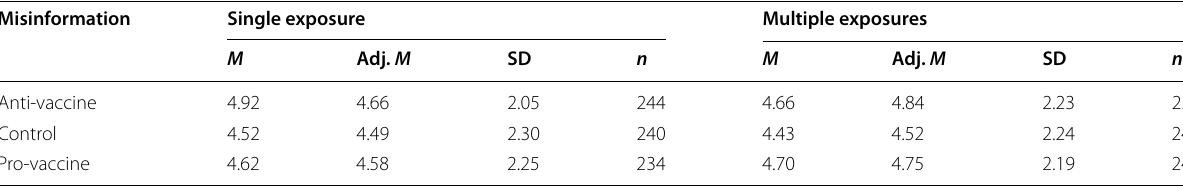
Table 3 Descriptive statistics of vaccination intentions per exposure (single vs. multiple) and misinformation (novel anti-vaccine vs. control vs. novel pro-vaccine) conditions, adjusted for pre-existing vaccine opinions